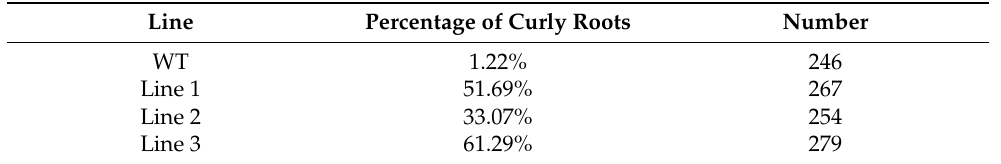
Figure 6. Root morphology of Arabidopsis p35S: LhWOX5 . The roots of 5–7 days seedlings were an- alyzed. ( A ) WT, wild type. ( B ) Line T3-1. ( C ) Line T3-2. ( D ) Line T3-3. Scale bar = 50 um, dark gray granules in the root tip indicate starch grains. 3. Discussion Plant roots are fundamental for plant growth, and their morphology strongly influ- ences their ability to absorb nutrients and water. A stable root system can ensure that woody plants grow to form wood or produce fruit. Several factors have been found to affect root growth in the model organism Arabidopsis thaliana [25]. WOX5 , a member of the WOX family, has been intensively studied because of its important role in root stem cell niche maintenance. In woody plants, Li et al. found that PtWOX5 in poplar promotes lat- eral root initiation but inhibits lateral root growth [18]. However, similar studies in woody plants are relatively rare due to their long life cycles and the fact that transgenesis is still uncommon. Here, we identified a single copy of the WOX5 gene in a Liriodendron hybrid and performed a pilot study on the function of this gene by overexpressing it in Arabidopsis through a heterologous expression system. Although previous studies have demonstrated that WOX5 has an important role in root development in many different plant species [9,14,18,19,26,27], we found that the ex- pression pattern of LhWOX5 is not the highest in the root of Liriodendron hybrid. The high- est LhWOX5 expression is present in the bud, suggesting that WOX5 may not only affect root development but also shoot apical formation in this species. Overexpression of LhWOX5 in Arabidopsis activates ectopic leaf and floral formation from the rosette leaves, as well as ectopic cell proliferation at curled stalk sites (Figure 3), a phenotype that is similar to that of AtWUS overexpression in Arabidopsis , which can induce ectopic flower buds on non-reproductive organs [28], suggesting that LhWOX5